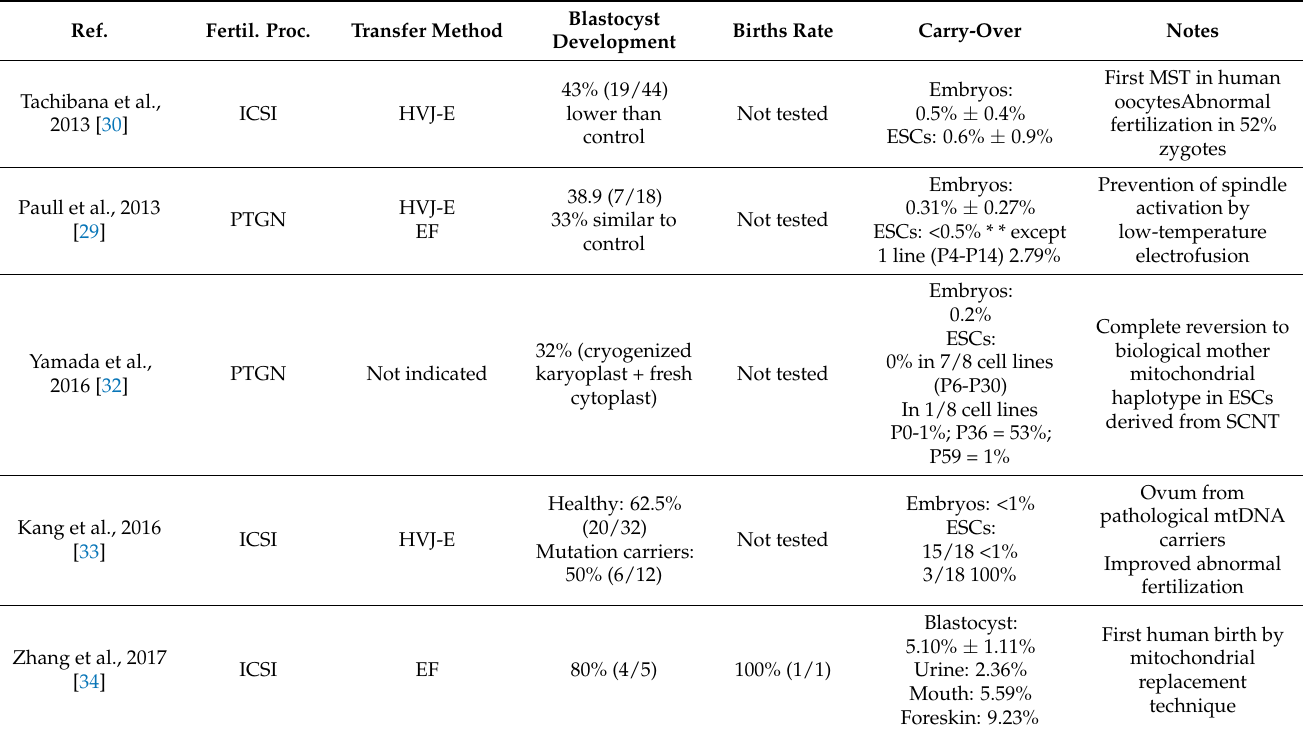
Table 4. Results of MST in